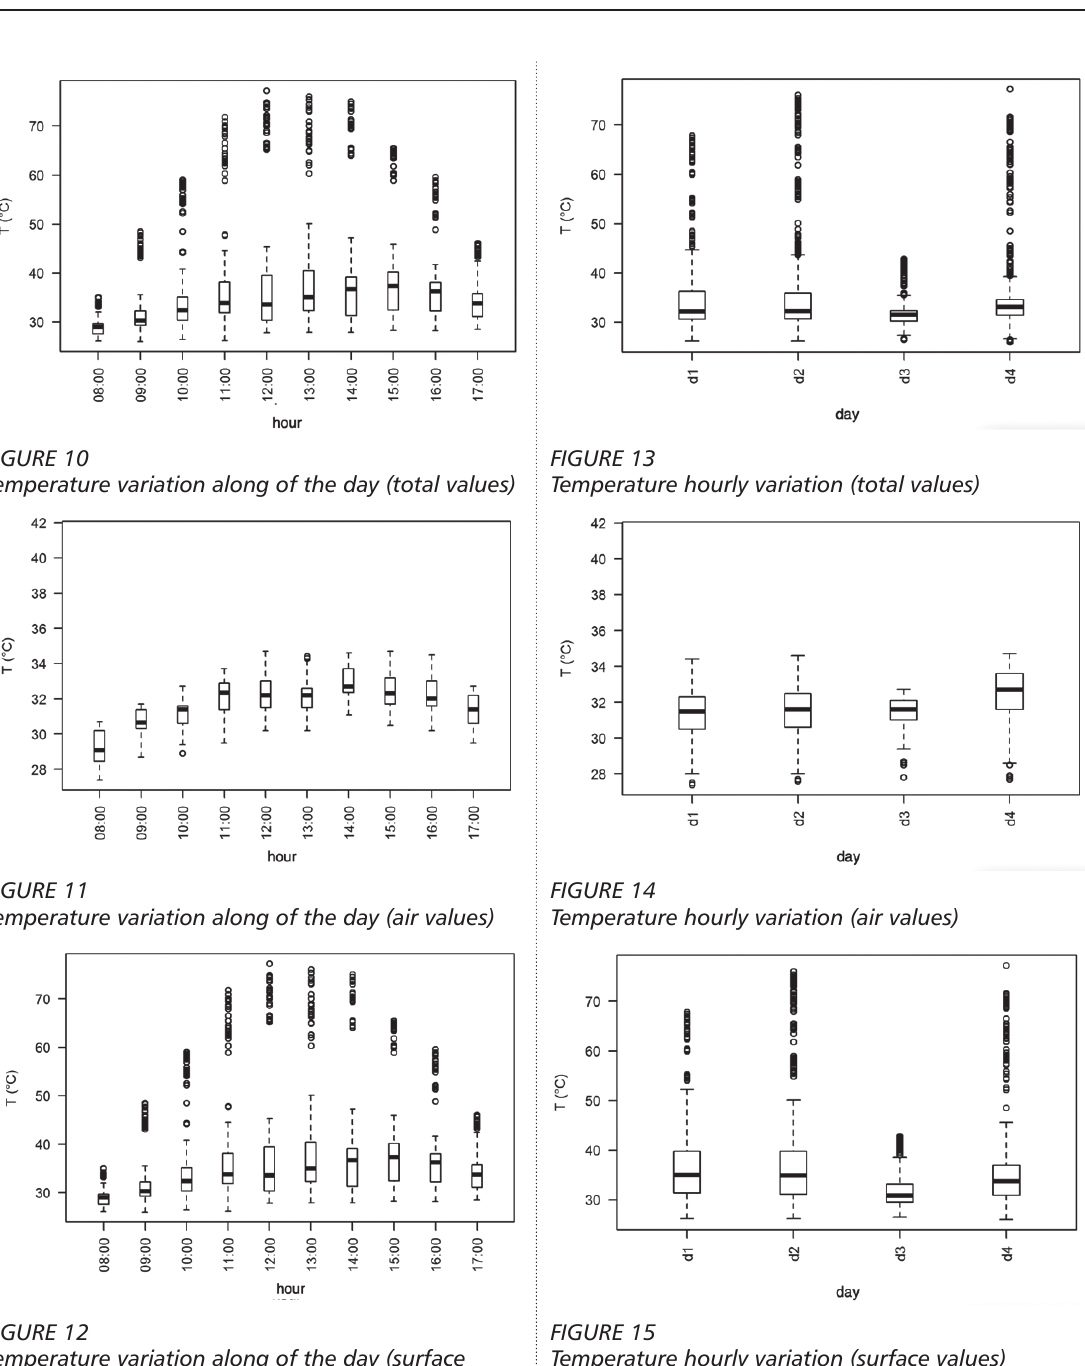
FIGURE 15 Temperature hourly variation (surface values) thermic attenuation. Regarding temperature data, the hour of the day shows the greatest influence on the variability of air temperature (Figure 19) and the species shows the greatest influence on the variability of surface temperature (Figure 20). These results are of the same magnitude as those reported in the literature for Mediterranean